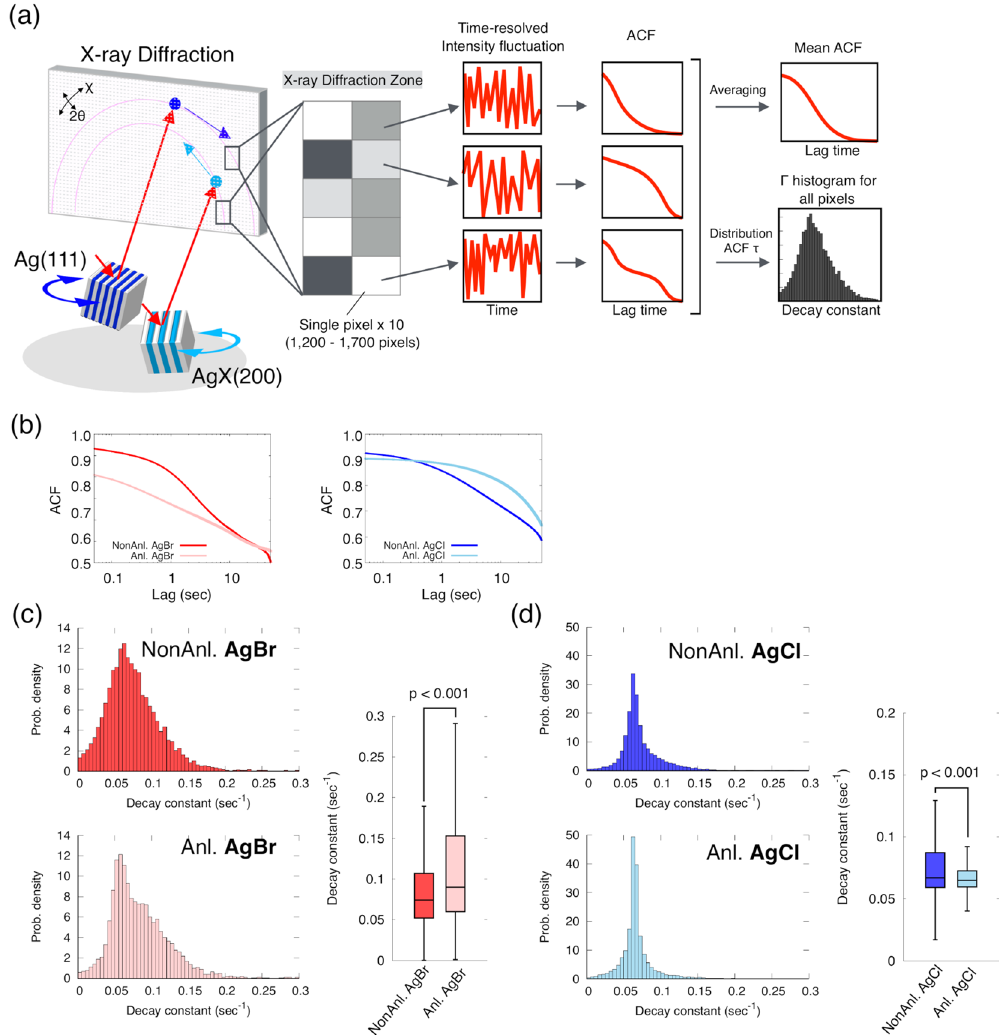
Figure 4. ACF analyses in silver halides AgX(200). ( a ) Concept of in situ DXB for dynamic measurement of crystal grains. The time-resolved intensity fluctuation in the X-ray diffraction zone is analysed by a single- pixel ACF. ( b ) Mean ACF curves for AgBr and AgCl. ( c , d ) Histogram and boxplot of decay constants. The distribution of the ACF decay constants was compared between non-annealed and annealed samples of AgBr and AgCl. The boxes show the median and first and third quartiles. The nonparametric Brunner–Munzel test was performed to compare two